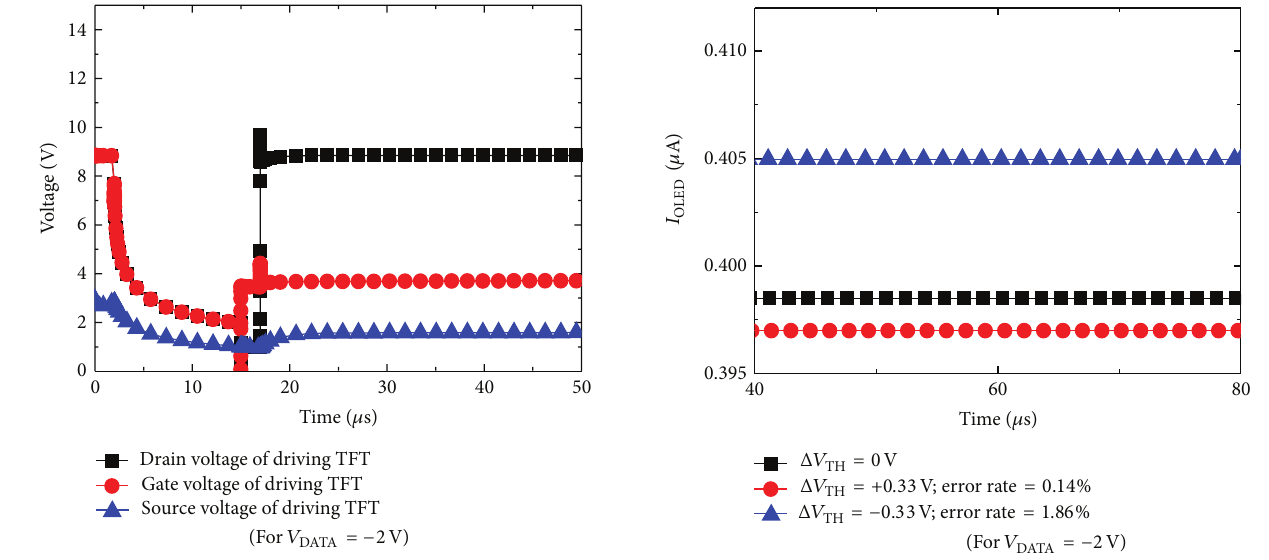
Figure 4: Gate, source, and drain voltage of DTFT with operation = −2 V. stages when 𝑉 DATA